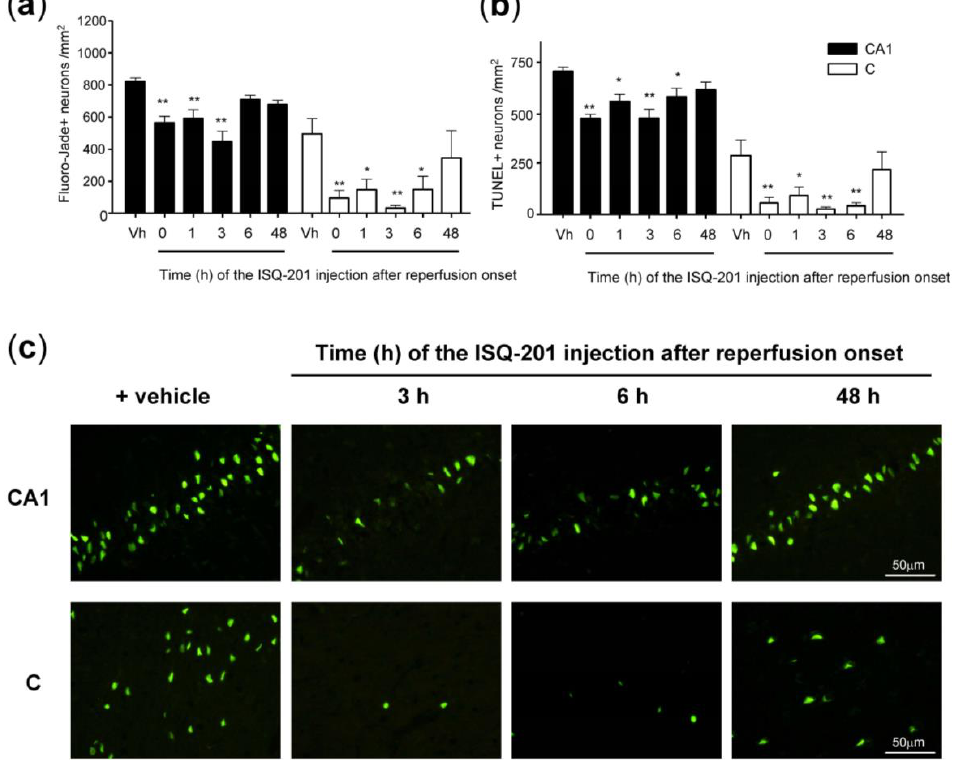
Figure 3. The therapeutic window of ISQ-201. Ischemic animals were treated with vehicle (Vh) or ISQ-201 (0.05 mg/kg), by an intravenous injection at the onset of reperfusion, or at 1, 3, 6, or 48 hours of reperfusion after global cerebral ischemia; and the neuroprotection of ISQ-201 was evaluated after 5 days of reperfusion, following ischemia. ( a ) The bar graph represents the neuronal death quantified in brain sections from vehicle- and ISQ-201-treated animals, after fixation and staining with Fluoro-Jade B. Neuroprotection was determined by quantification of the decrease of neuronal death in the hippocampal CA1 (CA1, black bars) and cortical (C, white bars) regions, as described in Materials and Methods. ( b ) The bar graph represents the apoptosis quantified in brain sections from vehicle- and ISQ-201-treated animals, through TUNEL assay. Neuroprotection was determined by quantification of the decrease of neuronal apoptosis in the CA1 and C regions, as described in Materials and Methods. ( c ) Images of the representative results of CA1 or C regions from vehicle- and ISQ-201-treated animals at 3 h, 6 h, or 48 h of reperfusion, after apoptosis detection by TUNEL assay and was visualized by fluorescence microscopy. TUNEL-positive cells were visualized in CA1 and C fields (in green). In ( a ) and ( b ), the data represent the mean of 6−7 independent animals, and the error bars indicate the SE, * p < 0.05 and ** p < 0.01, compared to their respective vehicle (Vh), through Dunnett’s post-test after ANOVA.